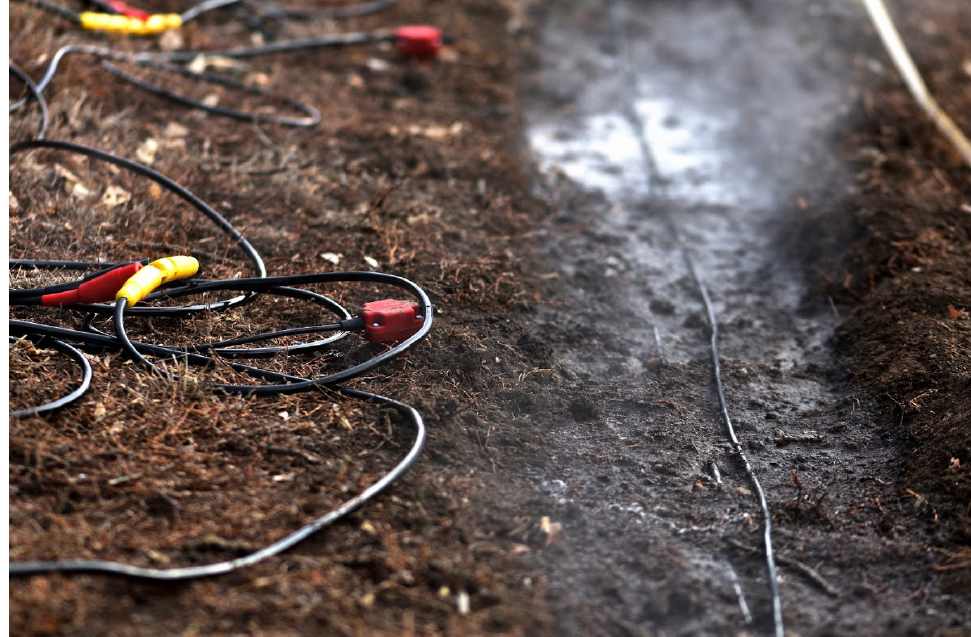
Figure 2. Fiber on Sections B and C with the deployed vertical geophones to the left. The steam is from water poured to freeze the fiber to the ground and improve the ground coupling. (Photo credit: I.